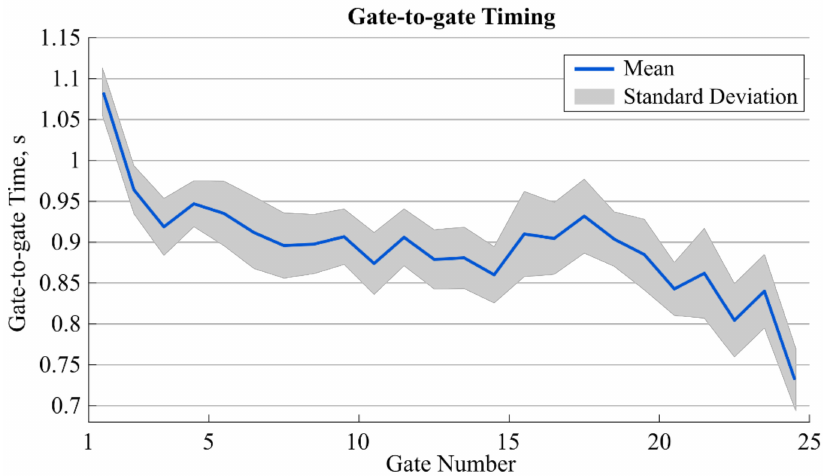
Figure 4. Mean (solid line) plus/minus one standard deviation (shaded area) for the gate-to-gate timing for all gates and the 16 runs. The value at position i + 0.5 refers to the gate-to-gate time between gates i and i +